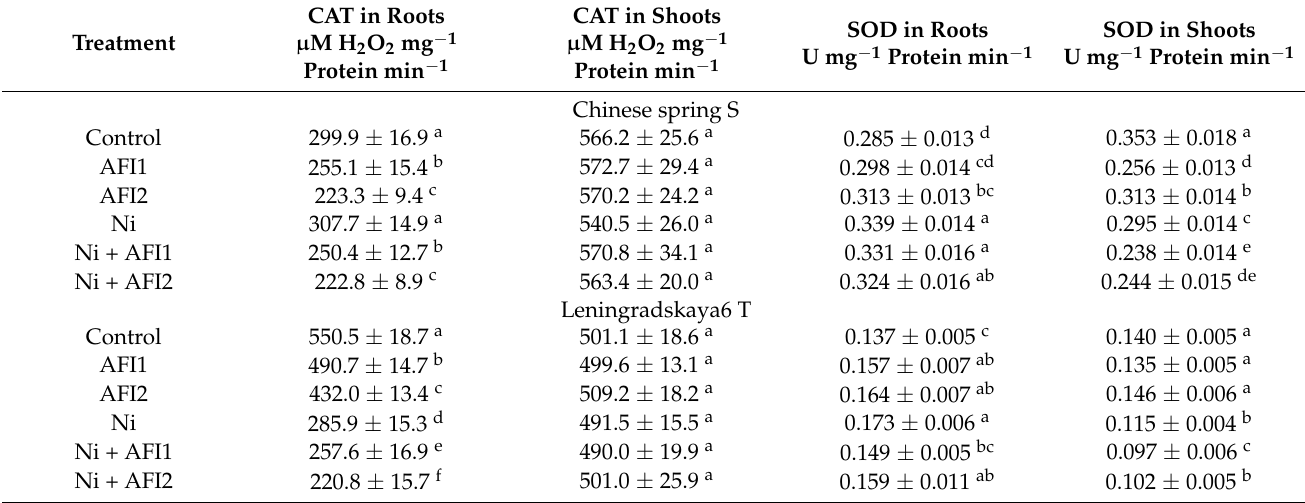
Table 4. Effects of PGPB on CAT ( µ M H 2 O 2 mg − 1 protein min − 1 ) and SOD (U mg − 1 protein min − 1 ) activities under Ni